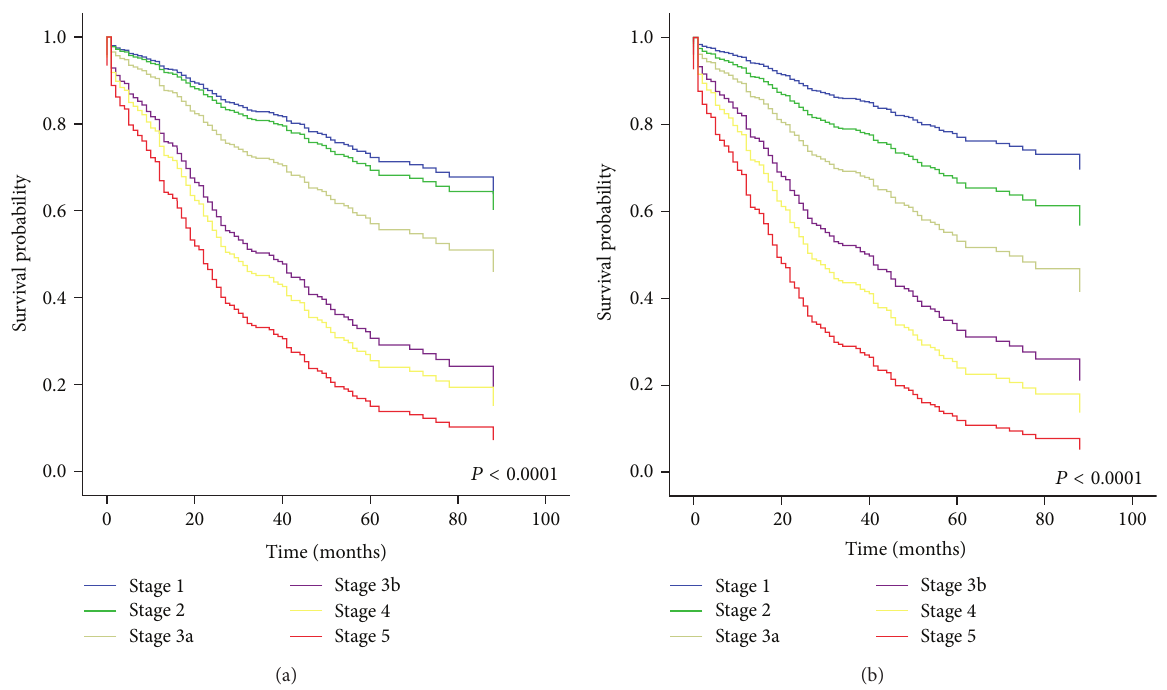
Figure 2: Cox-regression survival curve for doubling of serum creatinine level according to CKD stage for each eGFR equation: MDRD (a) and CKD-EPI (b). Age and sex are